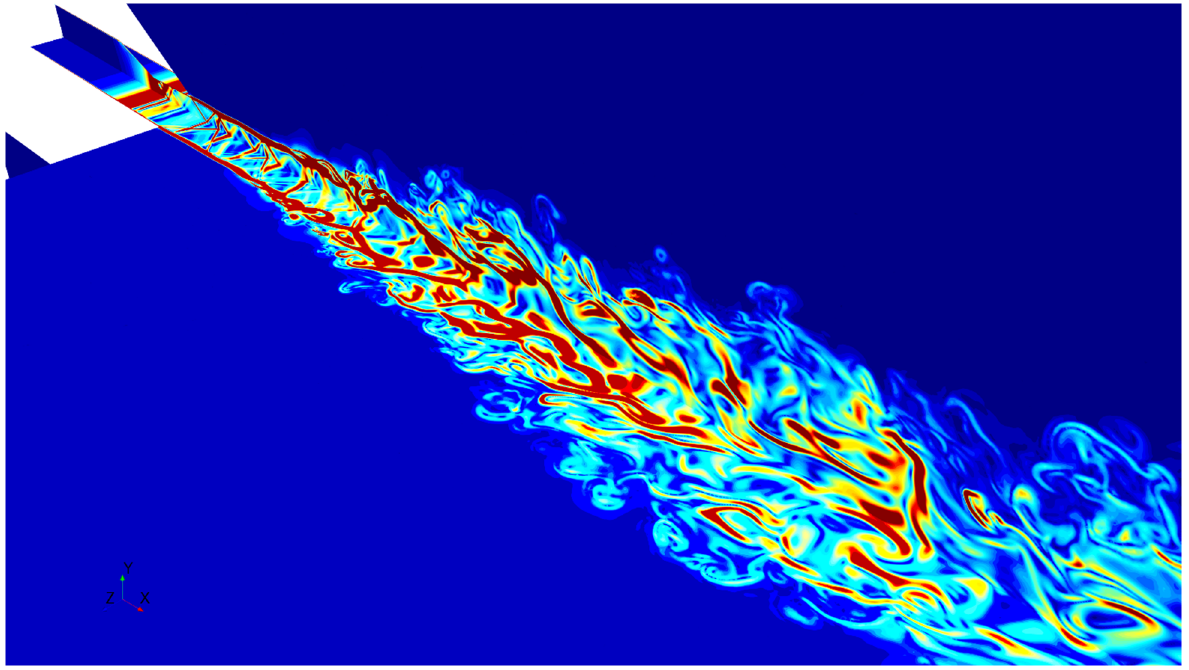
Figure 22 . TKE comparisons on minor ‐ and major ‐ axis shear layers with PIV data from [60].